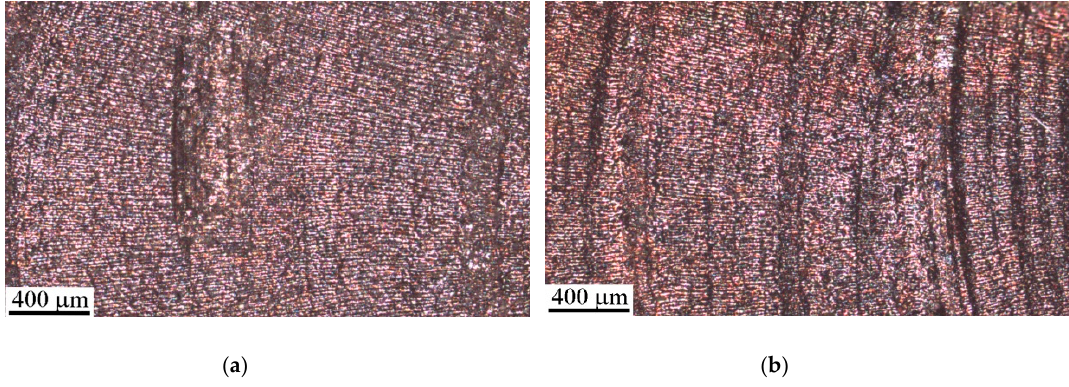
Figure 4. The laser confocal microscopic images of: ( a ) GTAW and ( b ) GTAW + EMS.